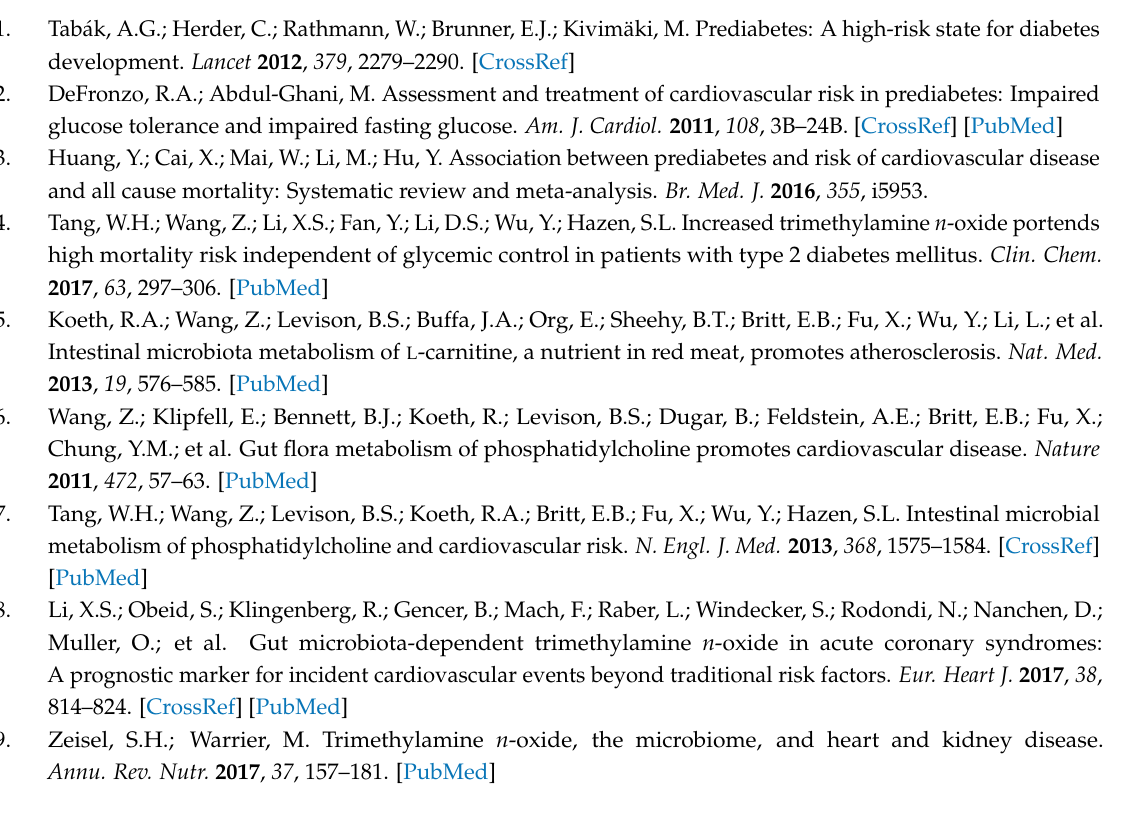
Table S1: Composition of standardized diet for the placebo and prebiotic groups, Table S2: Diet composition for each level of energy